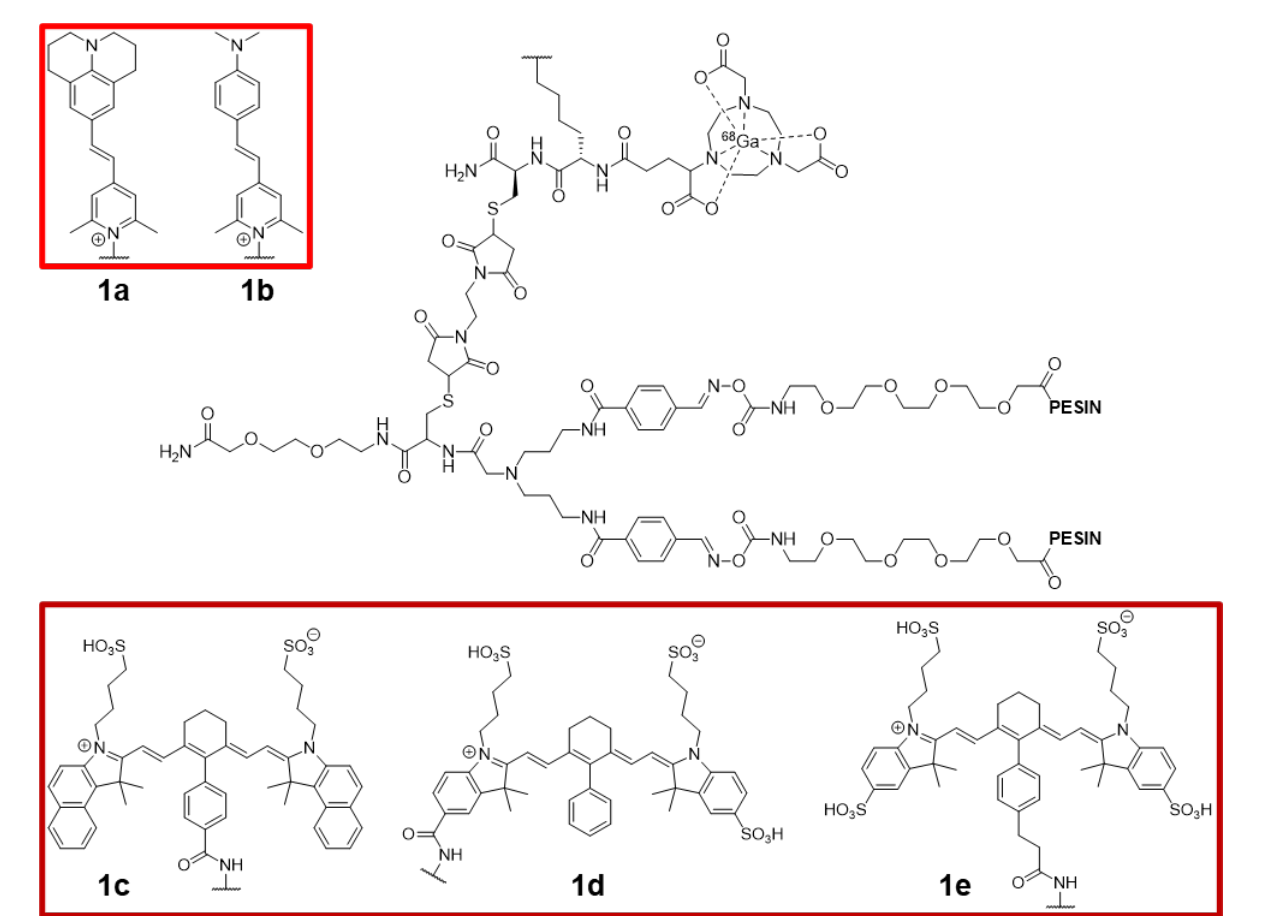
Figure 2. Structures of homodimeric PESIN-based dual probes 1a – e for GRPR